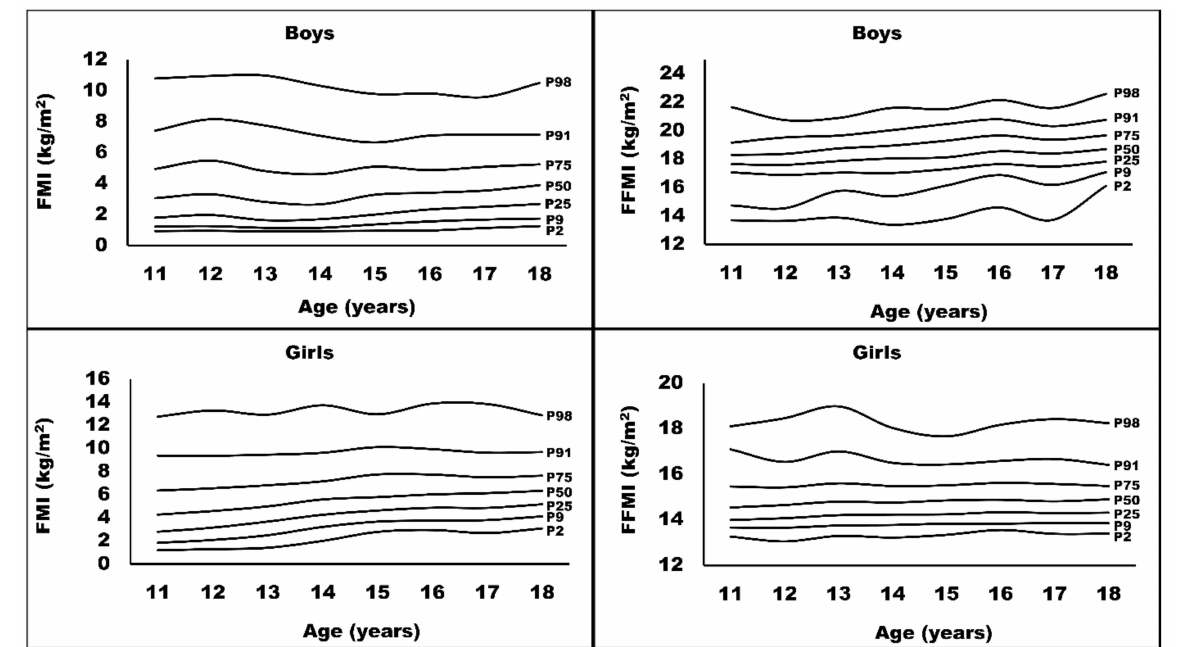
Figure 1. Sex-specific and age-specific percentiles for FMI (fat mass index) and FFMI (fat-free mass index) of the study participants ( n =